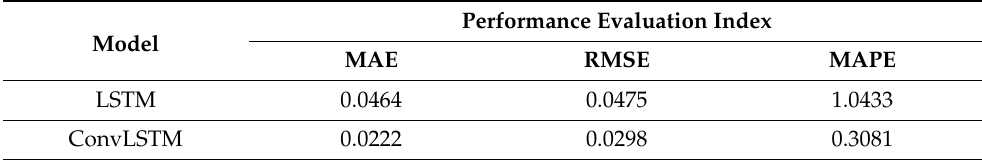
Table 3. Comparison of node prediction results of IEEE-39 bus